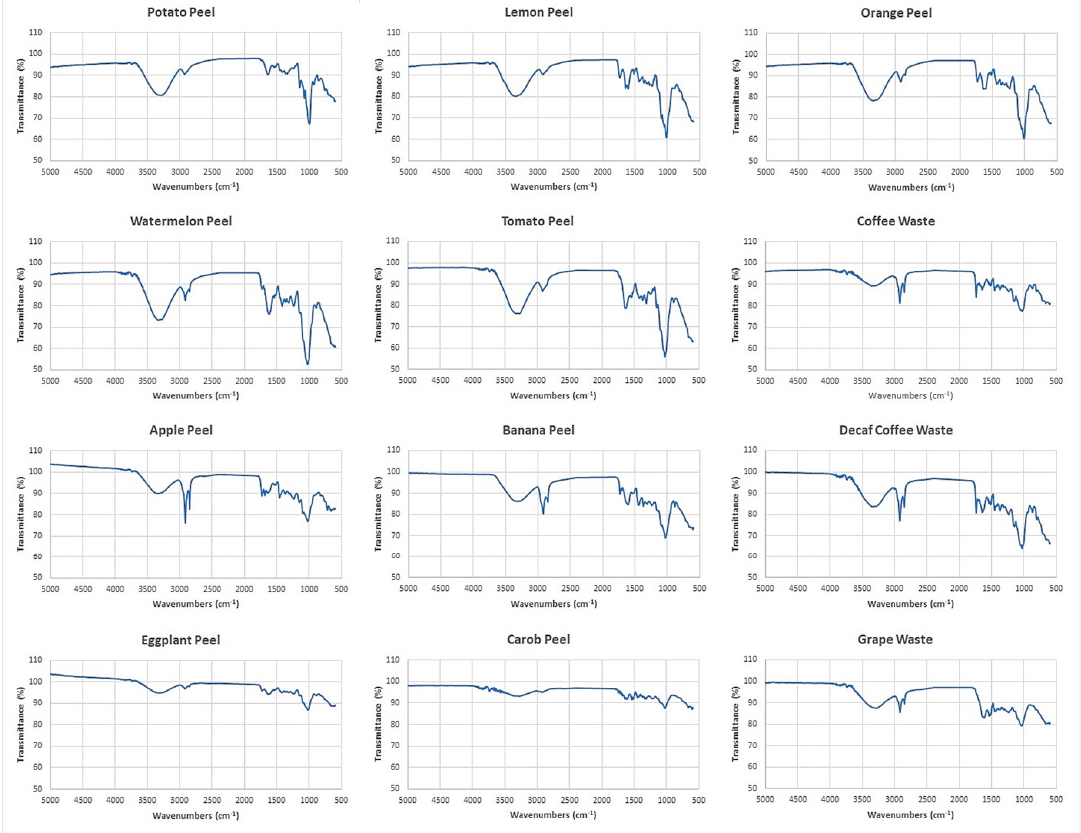
Figure 2 . Adsorbent ′ s FTIR spectra obtained by Fourier transform infrared spectroscopy (FTIR). Figure 2. Adsorbent (cid:48) s FTIR spectra obtained by Fourier transform infrared spectroscopy